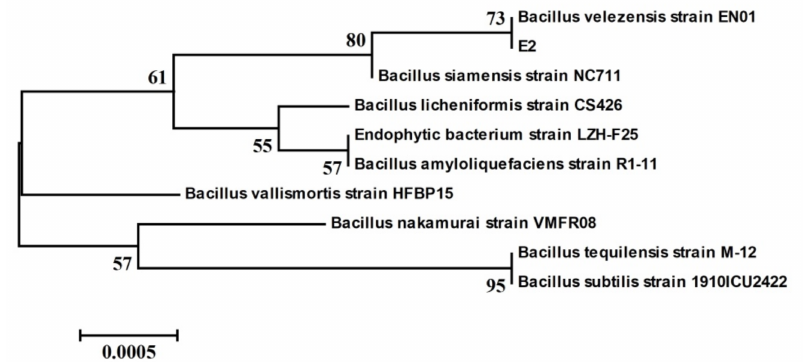
Figure 2. Phylogenetic tree of strain E2 based on 16S rDNA gene sequences. The phylogenetic tree was constructed by the neighbor-joining method using MEGA 6.0 software. The bootstrap values are shown at the branch points.